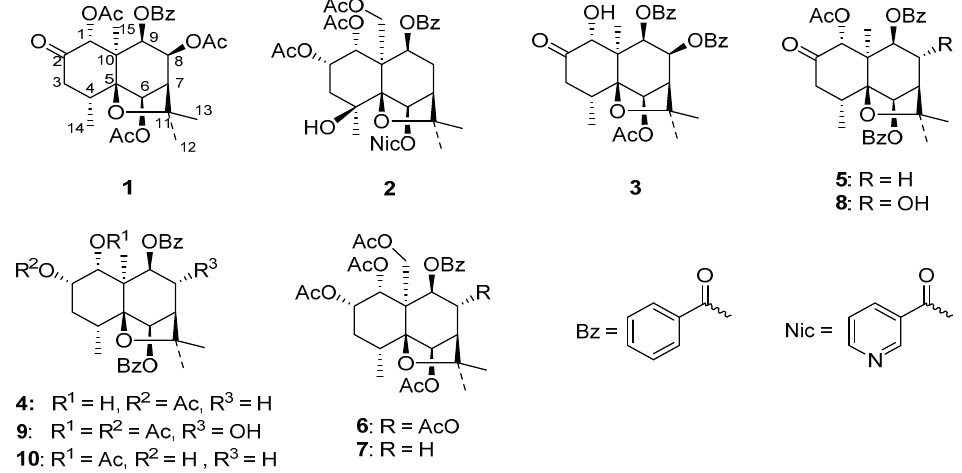
Figure 1. Structures of compounds 1 – 10 isolated from P. wightiana